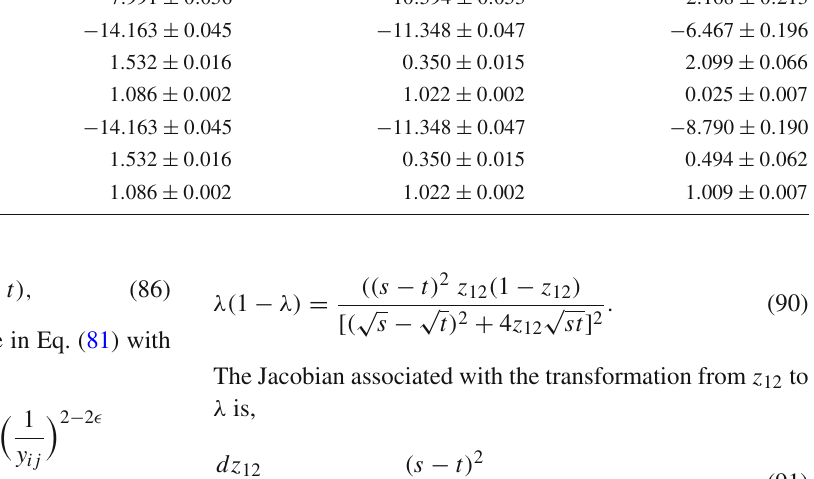
of the numerical fit of Eq. (74) for the three partonic configurations gg → g